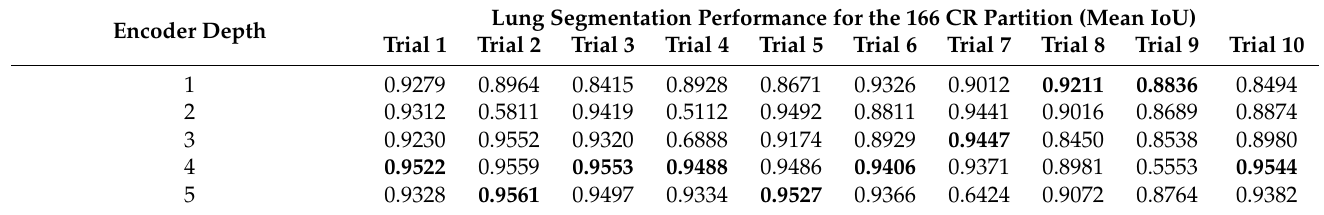
Table 3. Mean IoU values of the lung segmentations obtained for the 166 CR partition using U-Net. The highest IoU for each trial is marked in bold.